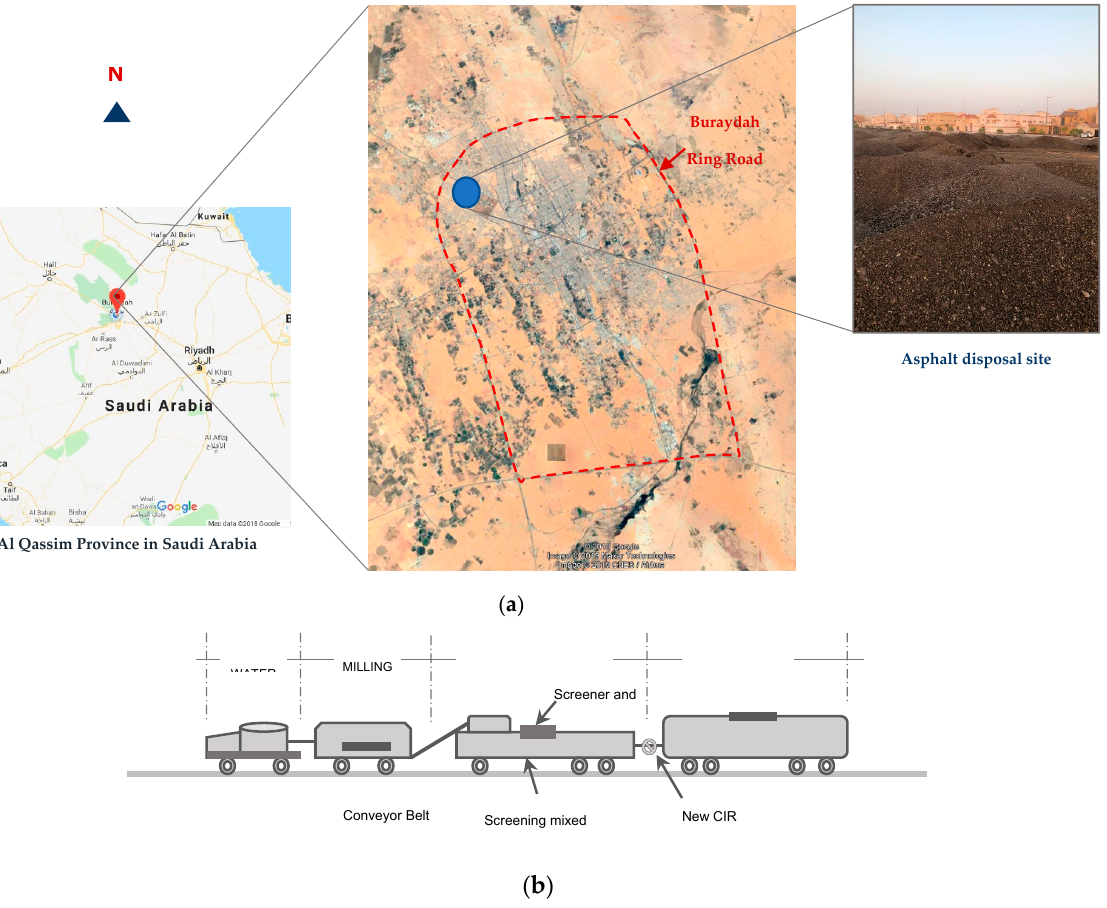
Figure 1. Study area and Cold in-place recycling (CIR) train, ( a ) Study area showing the open dumping at the asphalt disposal site in Buraydah, Qassim, ( b ) typical CIR train [16].